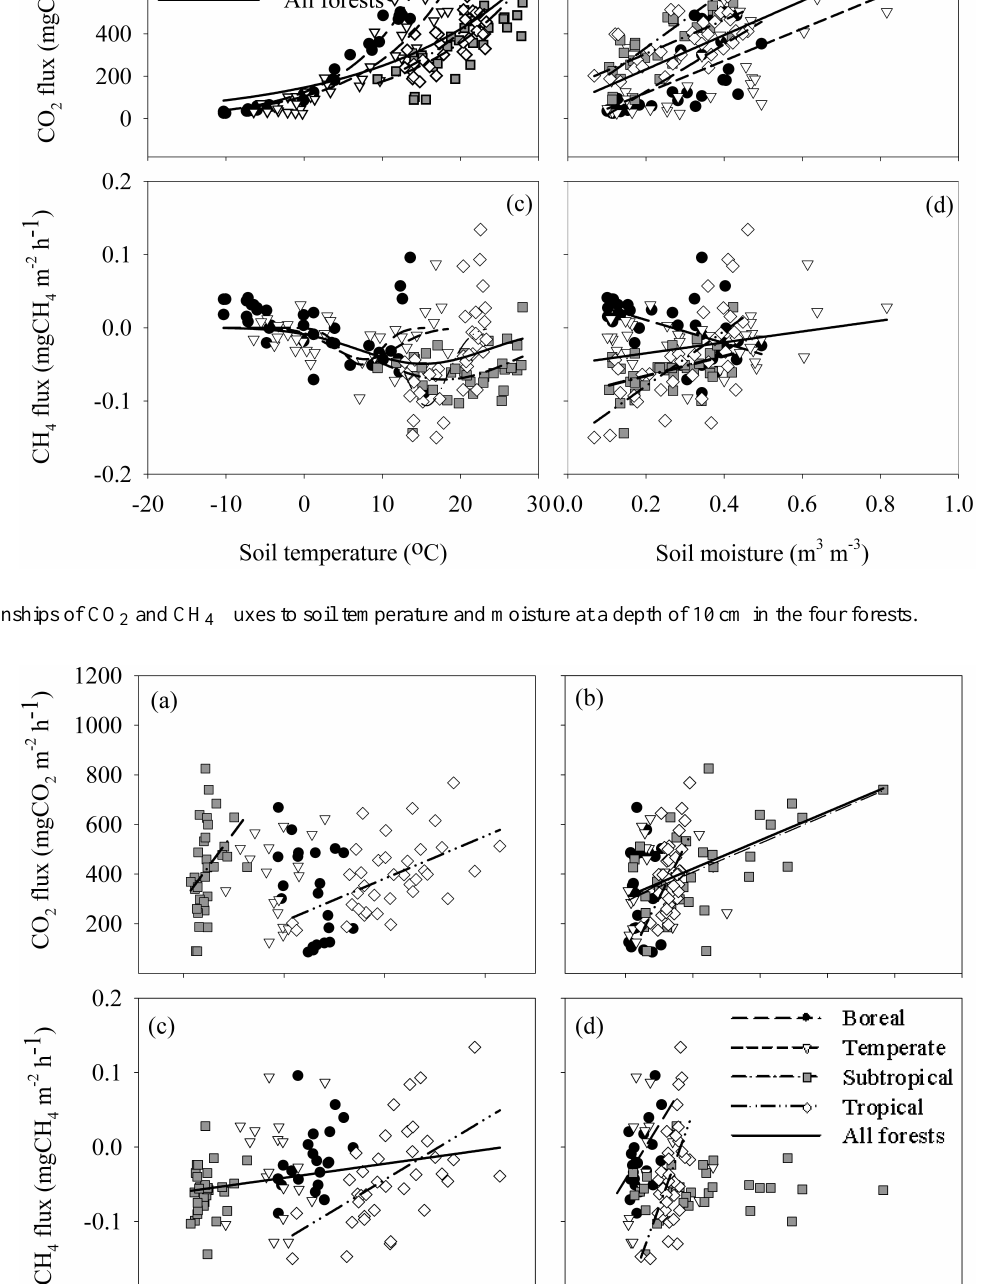
-N and NO − -N concentrations at a depth of 10cm in the four 4 3